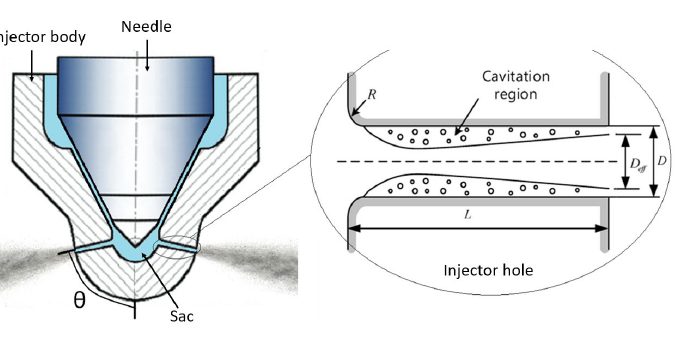
Figure 3. Schematic diagram of the injector nozzle and flow inside the hole of nozzle with